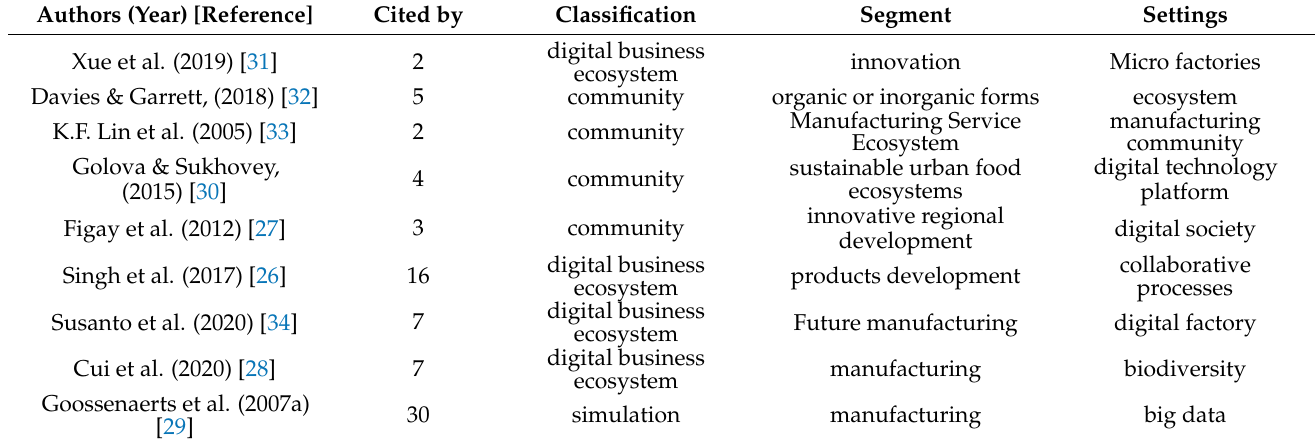
Table 3. Distribution of author, citations, and classifications from